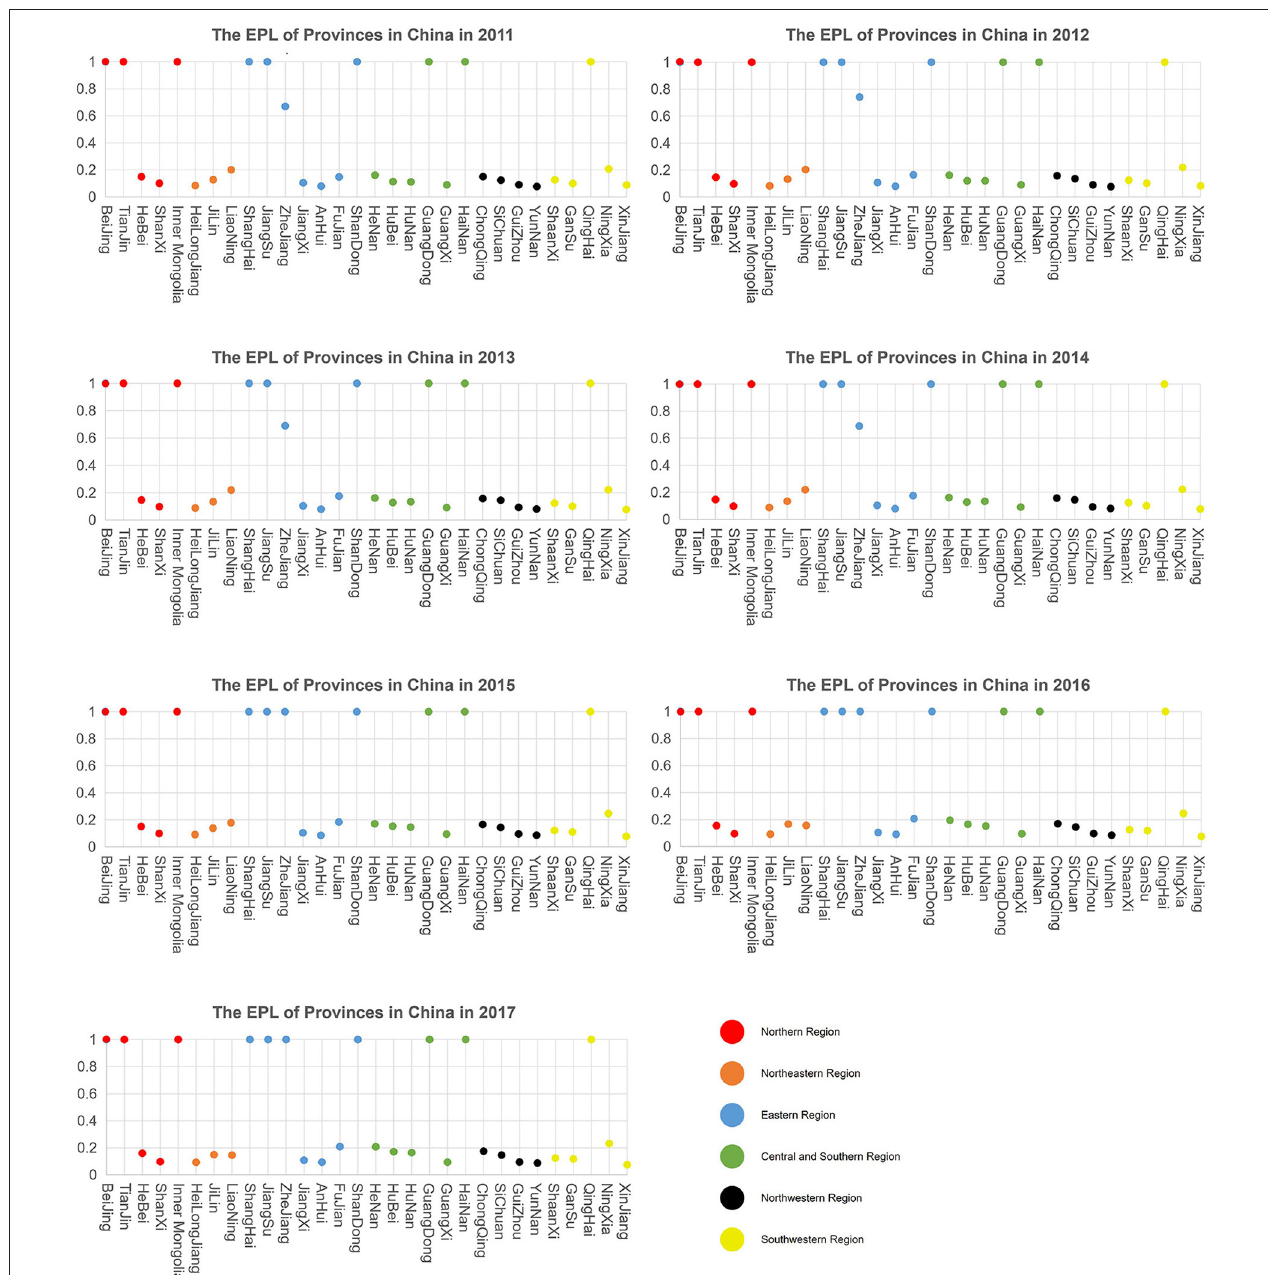
FIGURE 1 | EPL of various provinces in China by year.